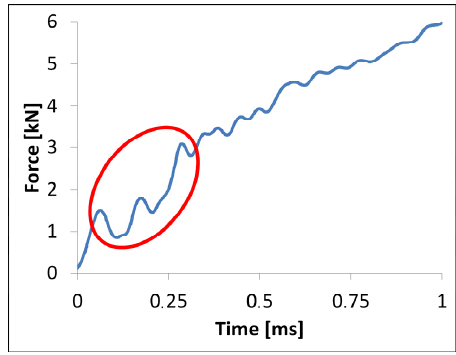
Figure 9. Impact force characteristics from 0 ms to 1 ms at 60 J impact energy at the FML.